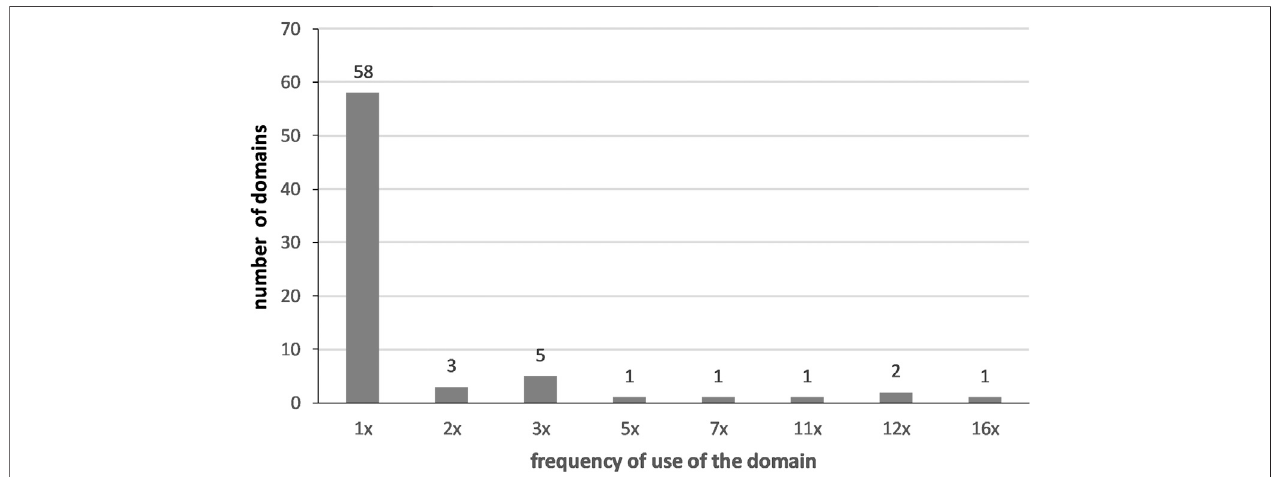
FIGURE 4 | Frequency of use of the 72 unique QOL domains (1x, 2x, 3x, ... nx (cid:1) the domain is used in 1, 2, 3, ... n tools).